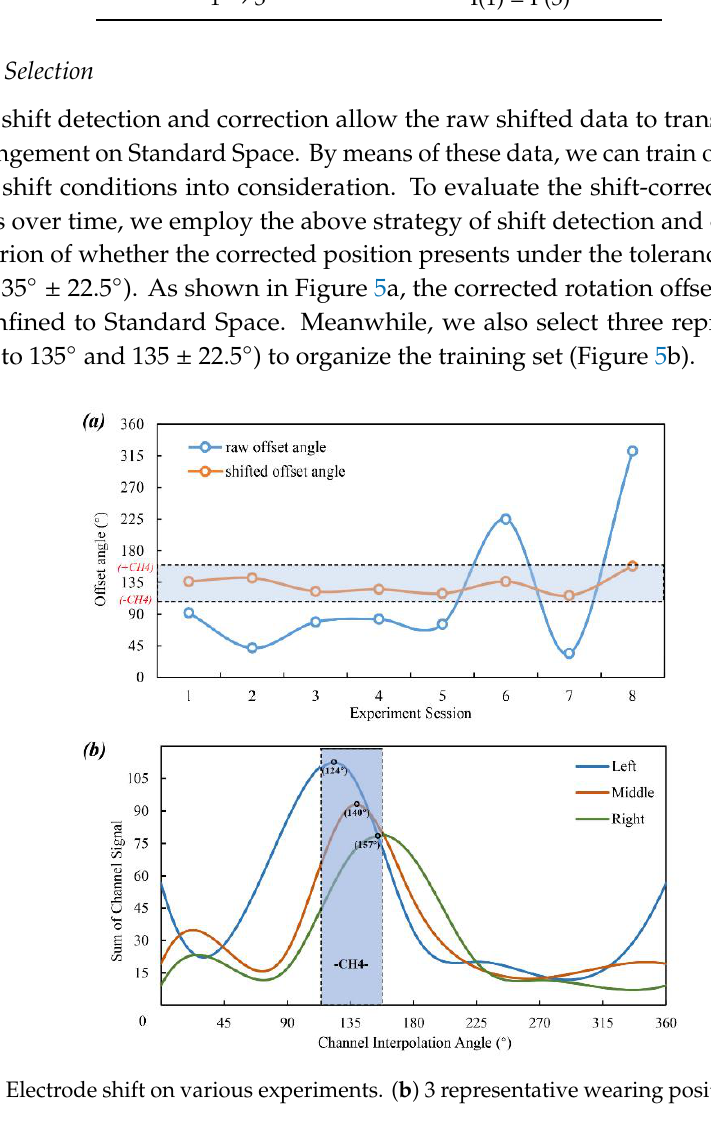
Table 1. The relation between raw and shifted channel.